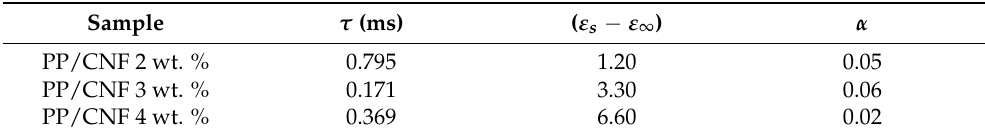
Table 2. Parameters τ , ( ε s − ε ∞ ) and α of PP/CNF composites extracted by the Cole–Cole model using Equation (9).